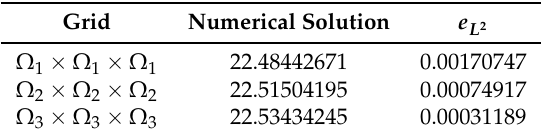
Table 3 lists the numerical solution of cash-or-nothing option at underlying assets x = y = z = 100 and its corresponding error e on grid Ω i × Ω i × Ω i for i = 1, 2, 3. From these results, we can confirm L 2 that FDM for option pricing is accurate. Table 3. Numerical prices and errors on different grids for three-asset option at x = y = z = 100. Here, u ( x , y , z , T ) =